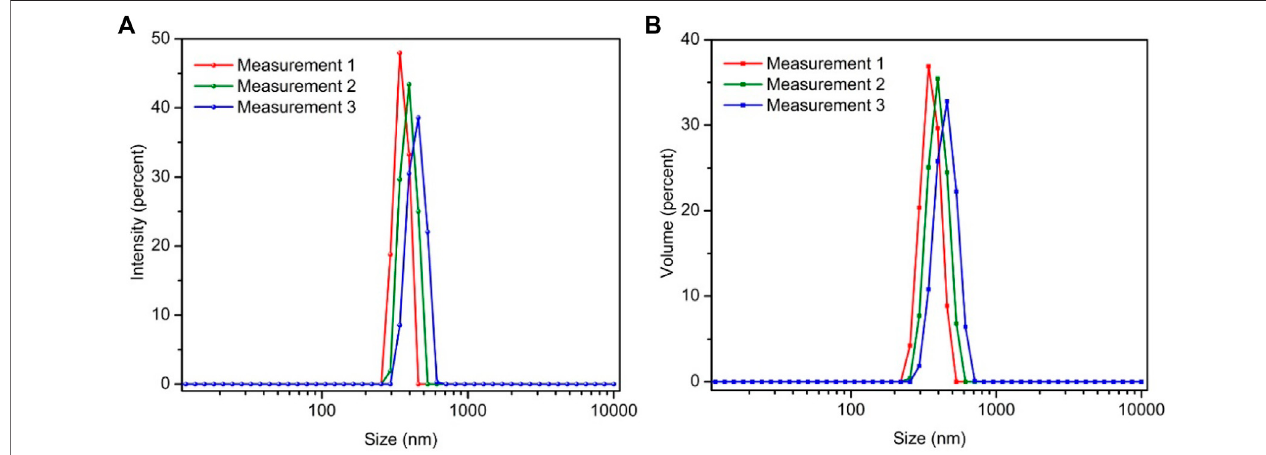
FIGURE 7 | Particle size distribution curves of DGP-W sample by intensity (A) and volume (B) . Measurements were repeated 3 times in